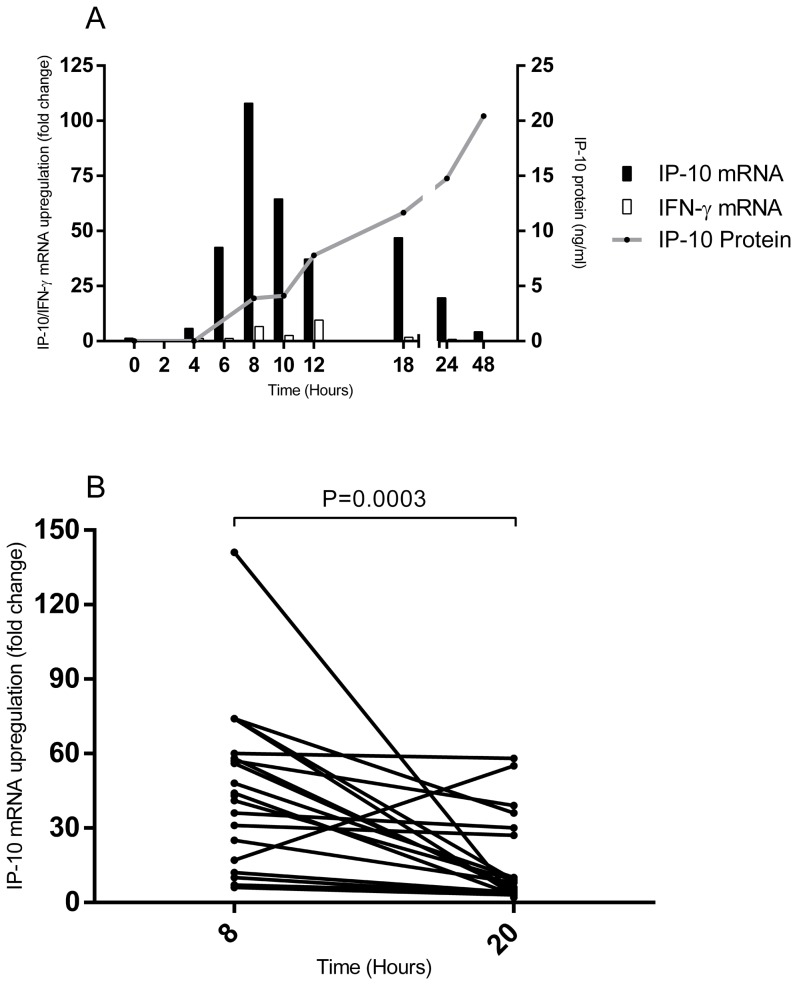
IP-10 and IFN-γ expression profiles.A: Whole blood from two TB patients and two persons with known QFT-TB positivity was incubated in QFT-TB tubes for up to 48 hours at 37°C. Every second hour for 12 hours and at 18, 24 and 48 hours post stimulation, dried blood spots were prepared for later mRNA extraction and plasma was isolated for protein analysis except for 2, 4 and 6 hours post stimulation. IP-10 and IFN-γ gene expression specified as mRNA fold change was determined using our RT-qPCR assay and IP-10 protein levels were determined using an in-house IP-10 ELISA assay. The black bars represent median IP-10 mRNA upregulation in fold change, the white bars represent the IFN-γ mRNA upregulation and the grey line represents the median IP-10 protein expression. IFN-γ protein expression was not measured in this experiment. B: Whole blood from 12 TB patients and 8 LTBI persons was incubated in QFT-TB tubes for up to 20 hours at 37°C. Dried blood spots were made after 8 hours incubation and after 20 hours incubation. mRNA was subsequently extracted and IP-10 mRNA fold change was determined using our RT-qPCR assay. The difference was analysed using a Wilcoxon matched pairs test p = 0.0003.